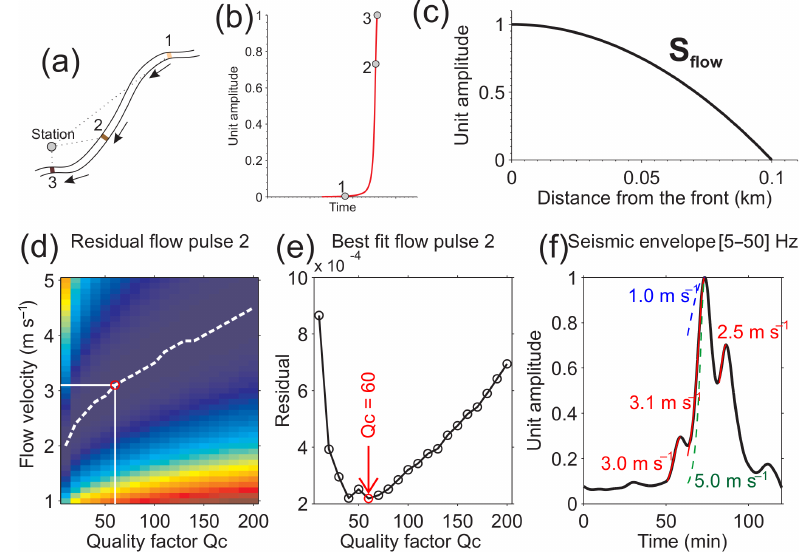
Figure 11. Flow pulse velocity measurement. (a) Schematic view of a flow propagating downstream. During the propagation, the flow front is getting closer to the seismic station, where the recorded seismic amplitude increases (b) due to smaller source–receiver distances. (c) Impact amplitude distribution for the debris-flow modelling. The largest sources are observed at the flow front and decrease rapidly towards the tail. (d) Residual for the velocity estimate of flow pulse 2 at IGB09 mapped in a quality factor ( Q c )–flow velocity domain. The most likely parameters that explain the recorded seismic signal are found by minimizing the residual (see Eq. 19). The white dashed line represents the local minima for each tested Q c . (e) Residual value for each Q c highlighted along the white dashed line in (a) . For flow pulse 2, the most likely Q c is 60 and the flow velocity is 3.1ms − 1 . (f) Seismic envelope at [5–50]Hz (black) recorded at IGB09 during the debris-flow sequence. The seismic data are smoothed with a 5min length window. In red and for each flow pulse, we show the best solution. To compare and for flow pulse 2, we show the pulse shape for a velocity of 1.0ms − 1 (blue dashed line) and 5.0ms − 1 (green dashed